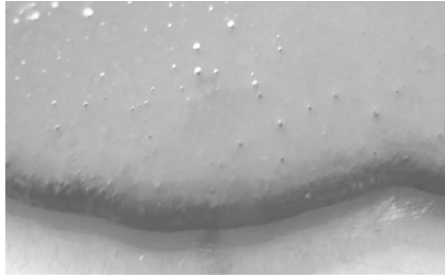
Fig. 13. The view of high stability of a concrete mix incorporating AFA Moreover, in case of a fresh mix containing AFA,